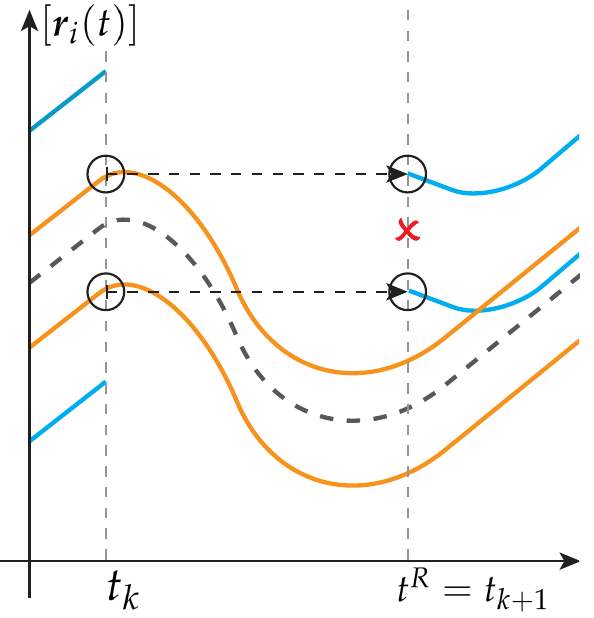
Figure 2. Re-initialization at time step t R = t k + 1 with initial values obtained at t k